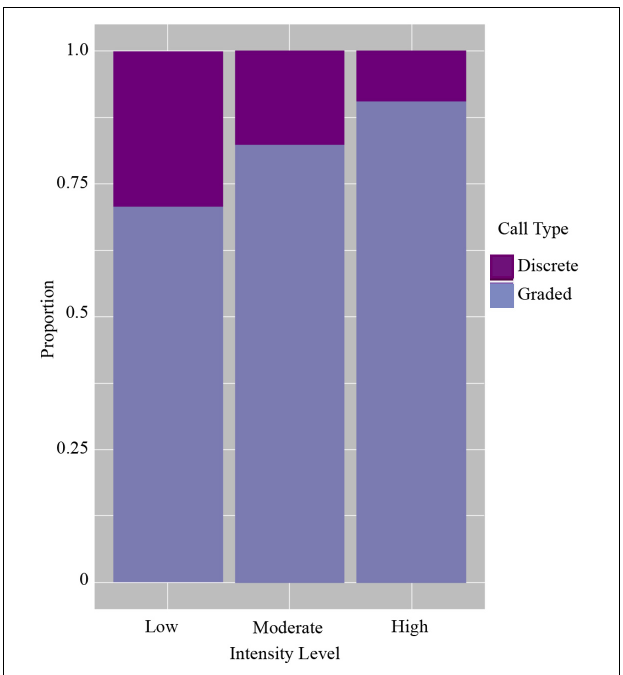
FIGURE 4 | Probability of detecting discrete and graded call types in the three intensity